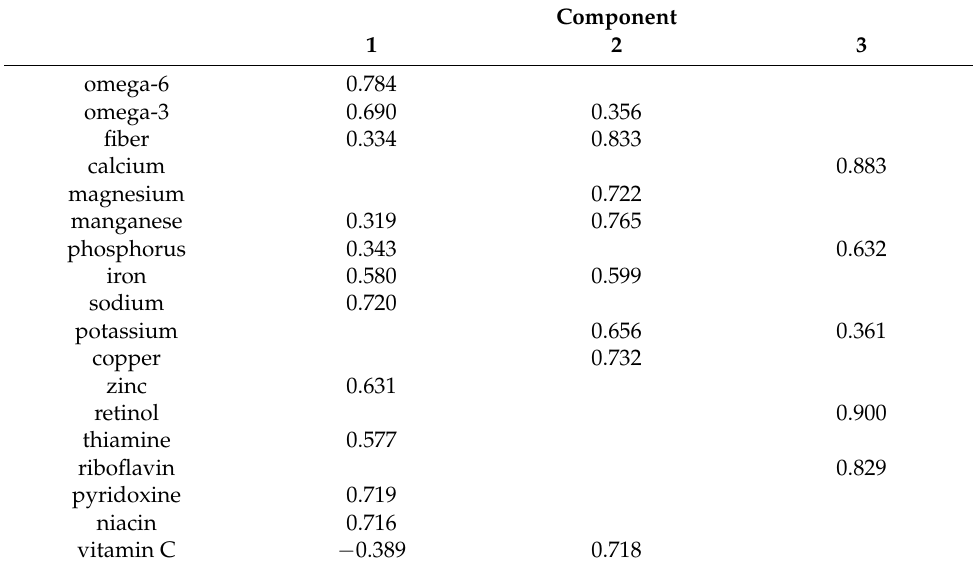
Table 2. Micronutrient intake patterns obtained by principal component analysis with oblimin rotation (three components retained).